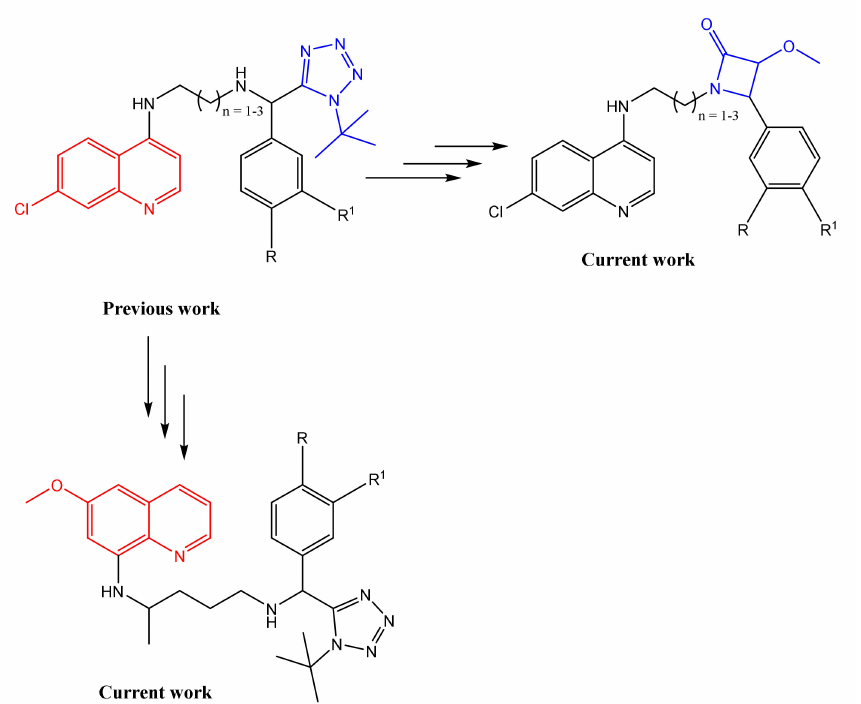
Figure 1. Rationale for the current